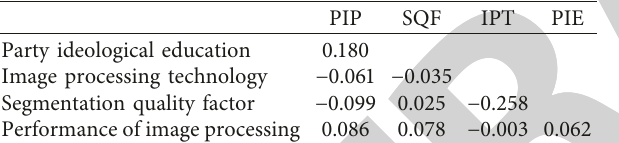
Table 8: Residual covariance.